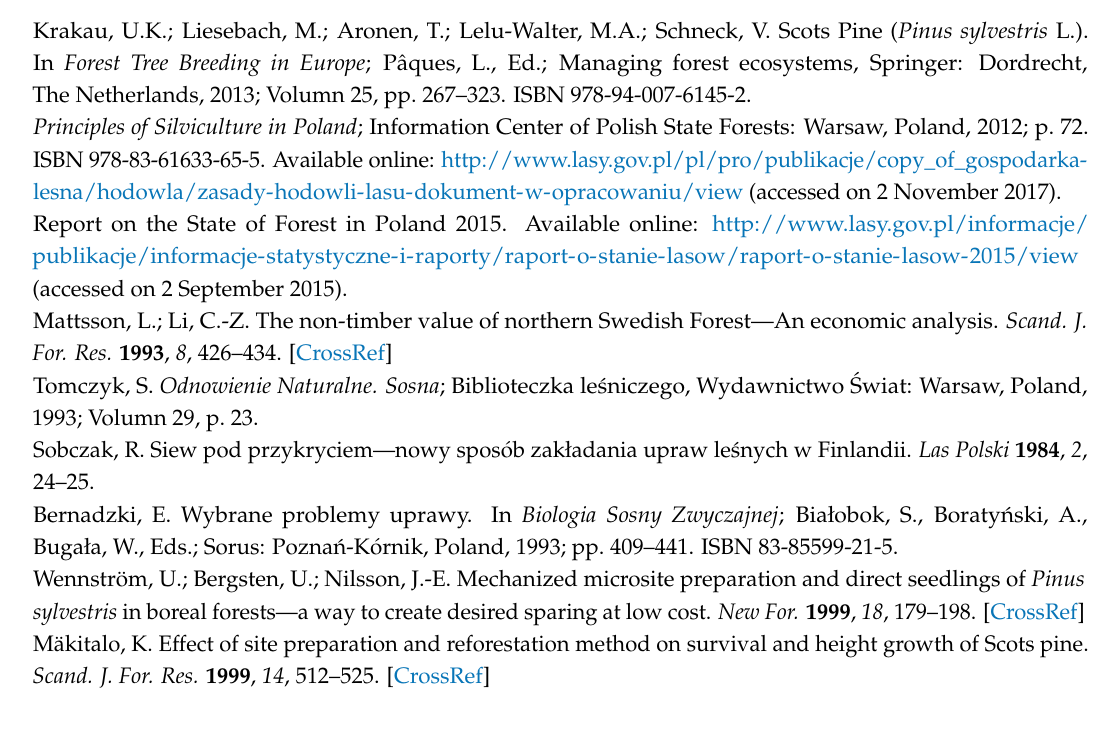
Figure S1: Evenness of seedling density (%) for Scots pine after natural regeneration in relation to MSP methods; Figure S2: Evenness of seedling density (%) for Scots pine after direct seeding in relation to MSP methods; Table S1: Results of 2-way ANOVAs describing the statistical significance of the effect of reforestation and of MSP methods on height, root collar diameter and density of Scots pine seedlings after four growing seasons; Table S2: Regression equations describing the relationships between height increments and height and between root collar diameter increments and root collar diameter of Scots pine